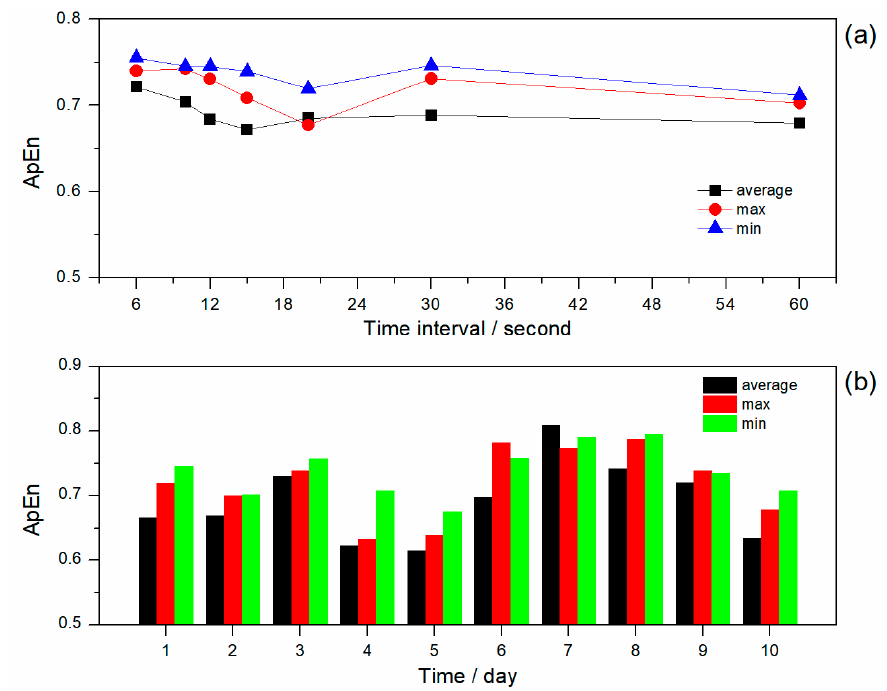
Figure 8. The ApEn values of observed wind speeds with different time intervals obtained by different sampling methods for ( a ) d1 and ( b ) d2; the average ApEn values for d1 and d4 with ( c ) different time intervals and ( d ) with the time interval of 6–60 s.